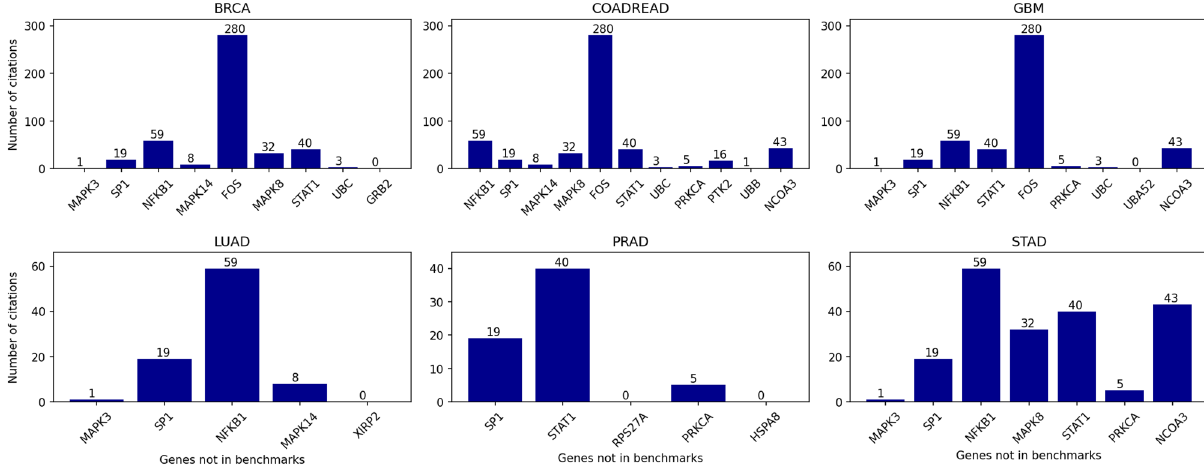
Figure 6. A secondary study for the DiSCaGe results: Number of papers (y-axis), reported by CancerMine, that mention specific genes (x-axis) as “ cancer gene ”. DiSCaGe prioritized the presented genes, and they are not contained in any known driver gene